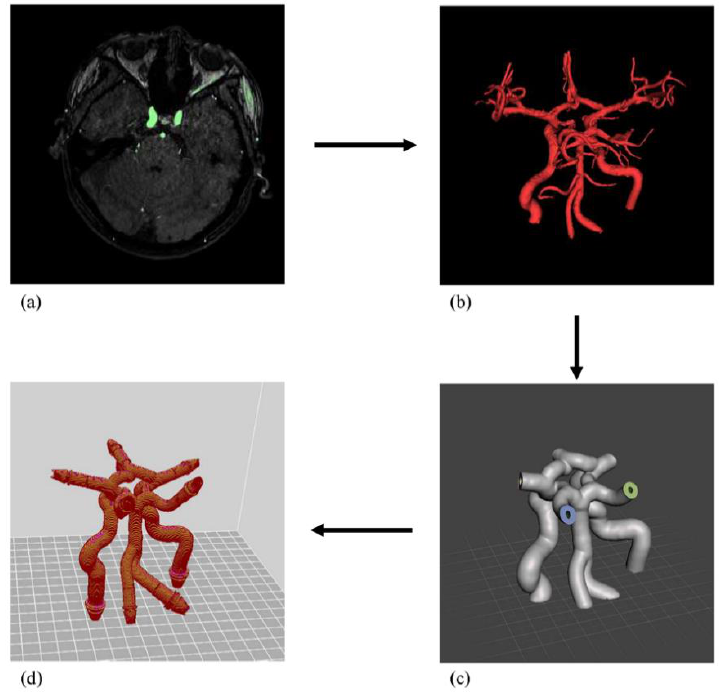
Figure 1. Workflow of three-dimensional (3D) vascular phantom manufactured from magnetic resonance angiography (MRA) images: ( a ) vessel segmentation from MRA images; ( b ) 3D model rendering; ( c ) refinement and modification for phantom; and ( d ) 3D model produced by a 3D printer. The black arrows indicate the